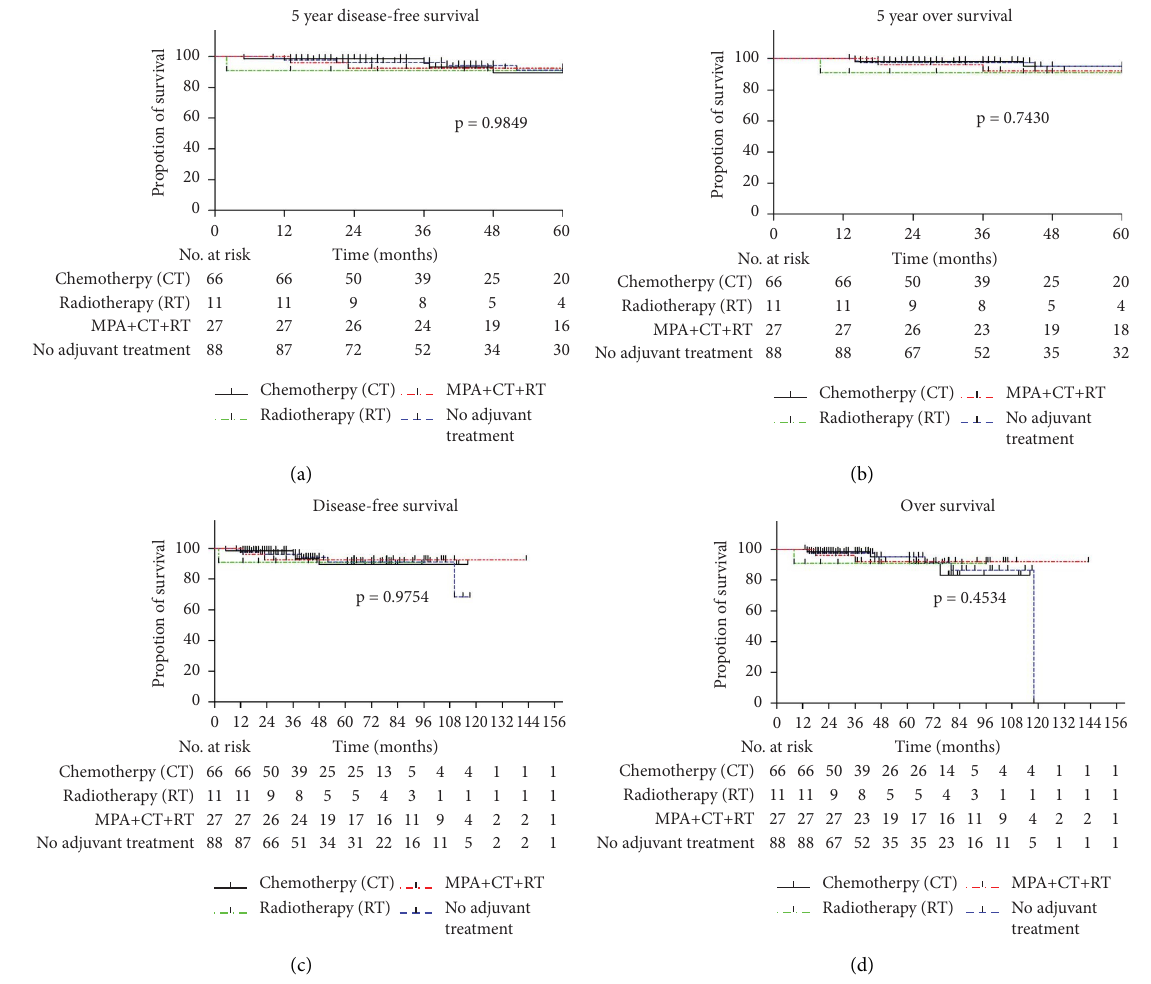
Figure 2: Kaplan-Meier estimates of the 5-year disease-specifc survival, 5-year overall survival, overall survival and disease-specifc survival among the four groups. Disease-free survival (a, c) and overall survival (b, d) after treatment with chemotherapy, radiotherapy or MPA+ radiotherapy/chemotherapy. Patients who received no adjuvant treatment after surgery served as controls. Te corresponding P -values are 0.9849, 0.7430, 0.9754 and 0.4534, respectively. Tick marks indicate censored